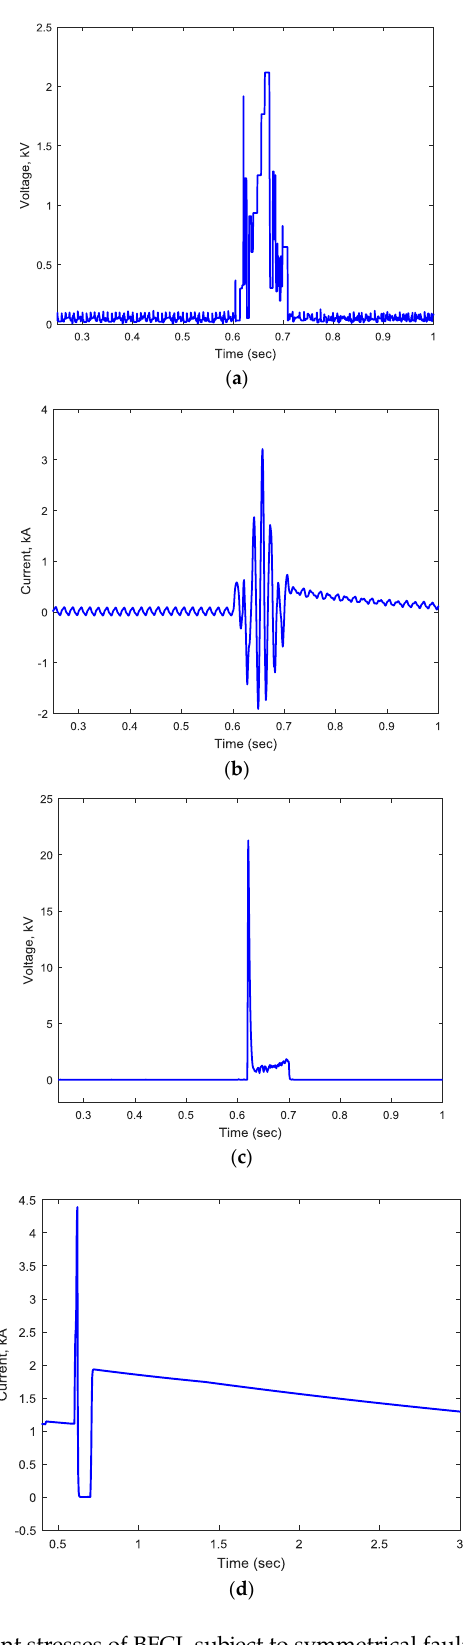
Figure 6. Voltage and current stresses of BFCL subject to symmetrical fault at grid1 ( a ) Voltage across shunt branch ( b ) Current through the shunt branch ( c ) Voltage across IGBT switch ( d ) Current through IGBT switch.